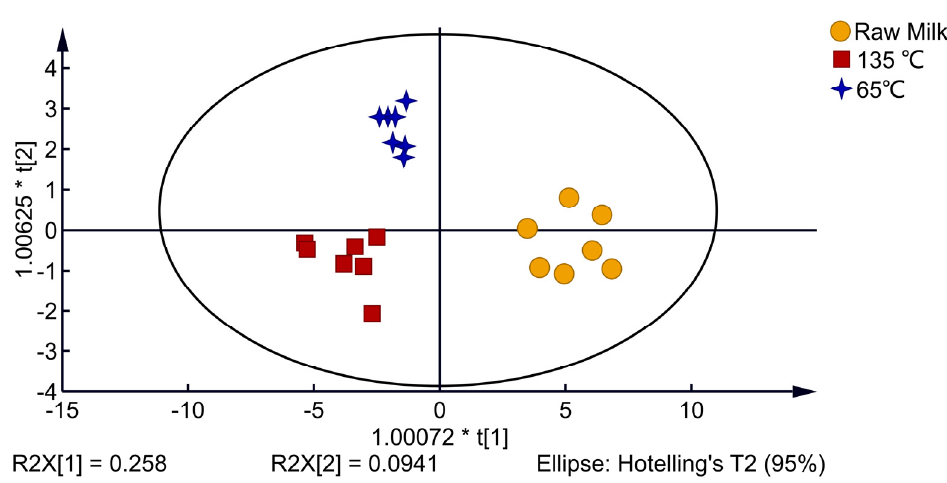
Figure 5. OPLS-DA 2D score map of milk with different processing temperatures.